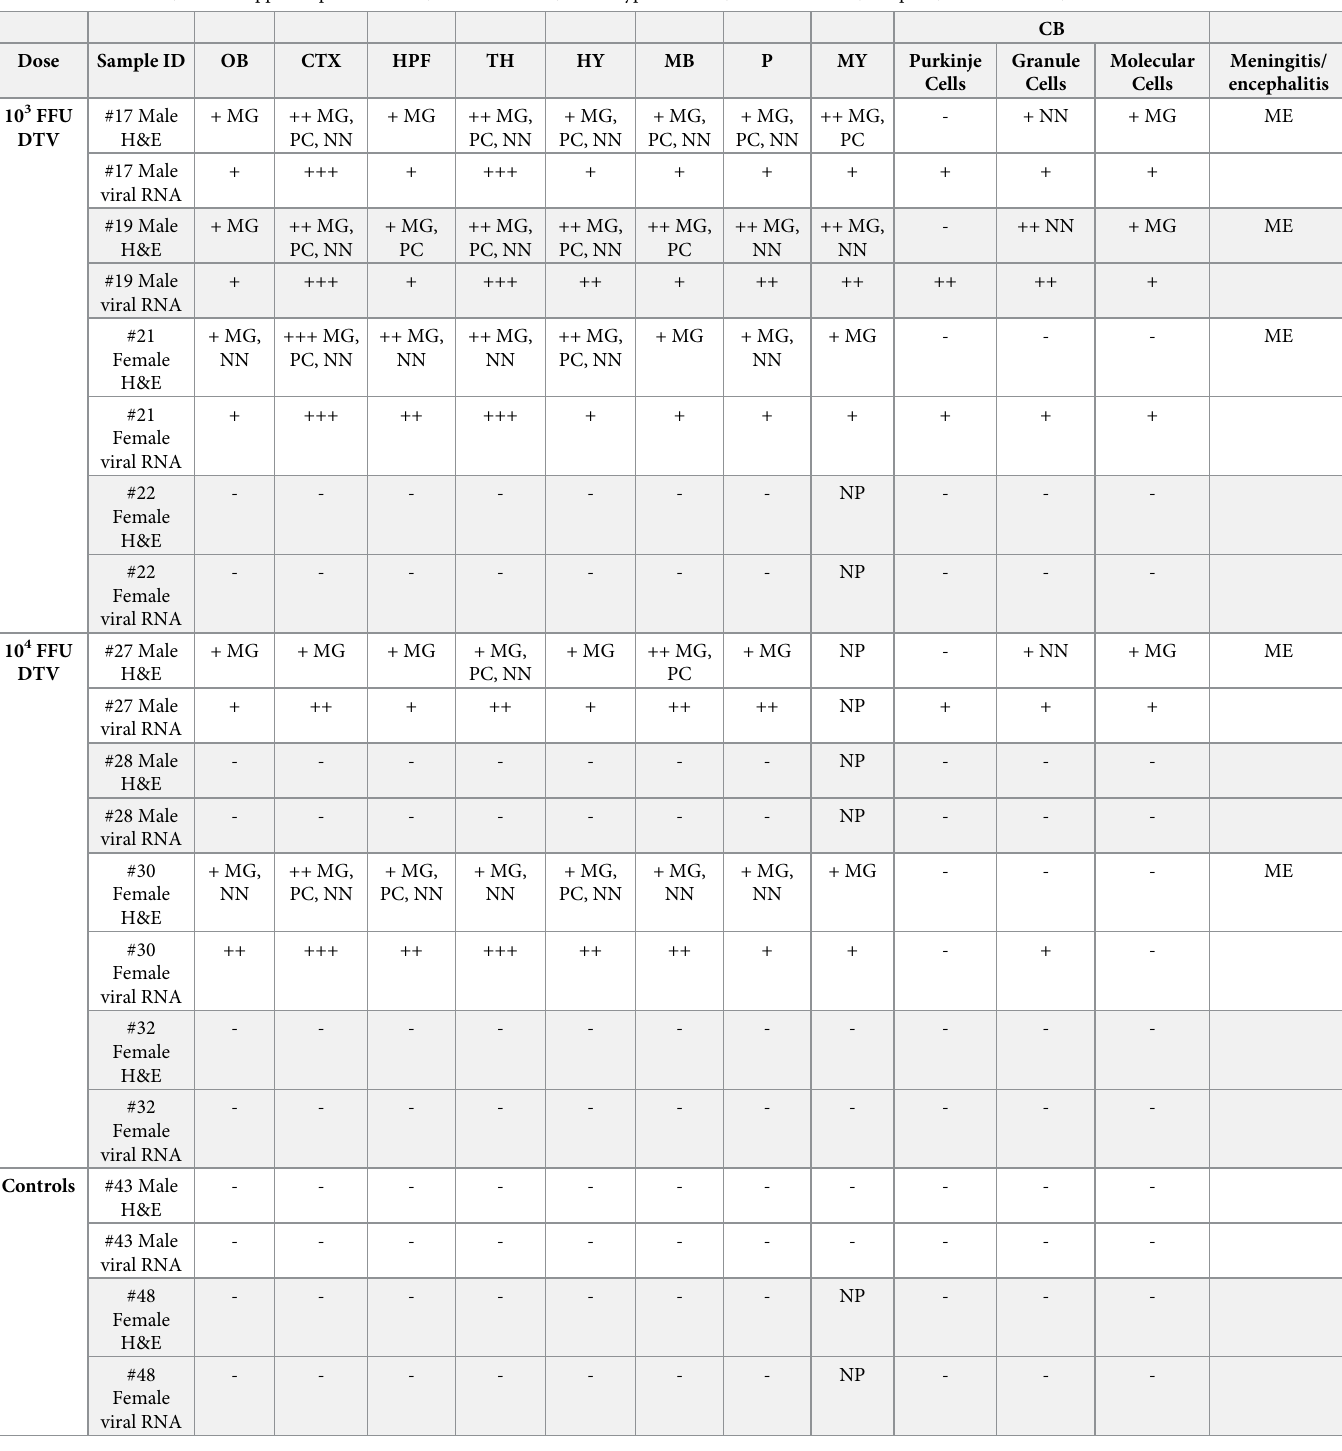
Table 1. Distribution and severity of histologic lesions and detection of viral RNA in the brain of DTV-infected mice. Sagittal brain sections were examined in the rostro-caudal direction. Each mouse was represented by an H&E-stained section as well as a section stained for viral RNA (teal signal) by RNA in situ hybridization. Viral RNA staining score was graded as — (absence of staining), + (very few to low), ++ (moderate), +++ (numerous). Microscopic lesions, including microgliosis (MG), peri- vascular cuffing (PC), and/or neuronal necrosis (NN), were graded as – (absence of lesions), + (minimal), ++ (mild), +++ (marked). The presence of meningitis, encephali- tis, or meningoencephalitis was coded in the last column of the table as M, E, or ME, respectively. NP = region not present on the slide. OB = olfactory bulb, CTX = cerebral cortex, HPF = hippocampal formation, TH = thalamus, HY = hypothalamus, MB = midbrain, P = pons, MY = medulla, CB =